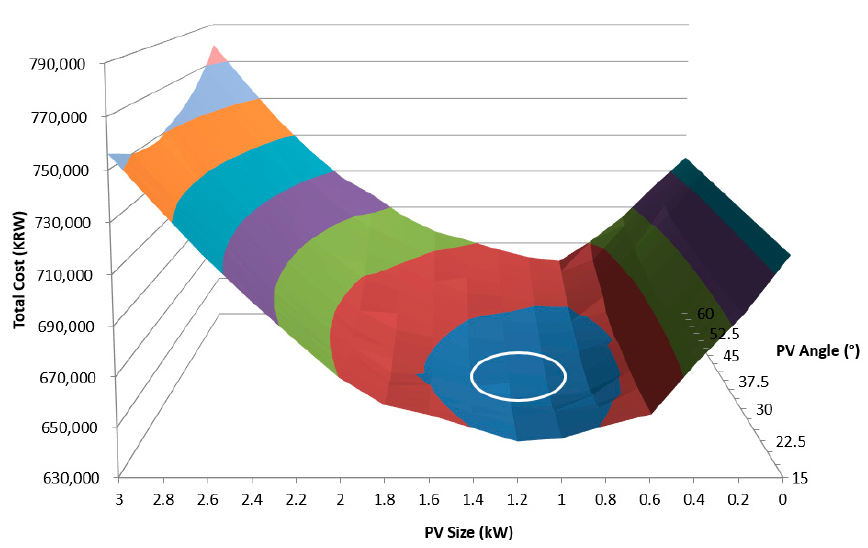
Figure 5. The total PV design cost.